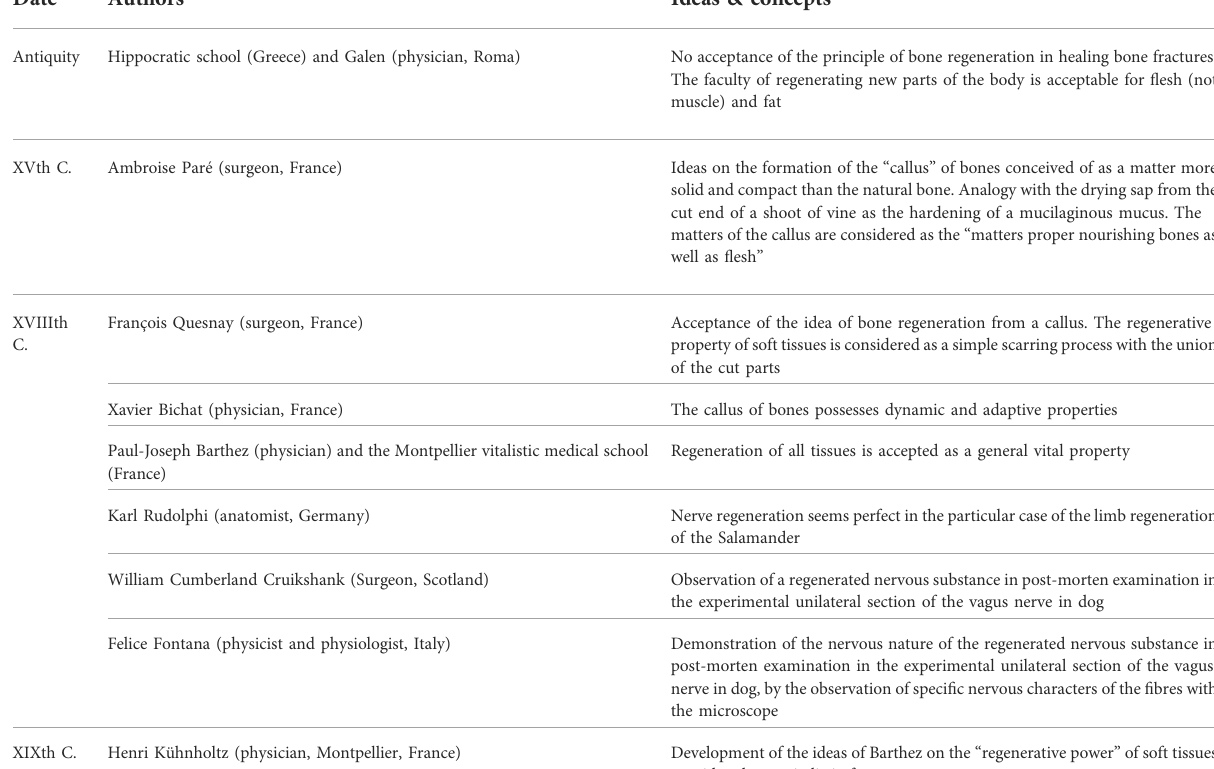
TABLE 1 Chronology of some ideas and concepts relative to the regeneration of tissues included in the